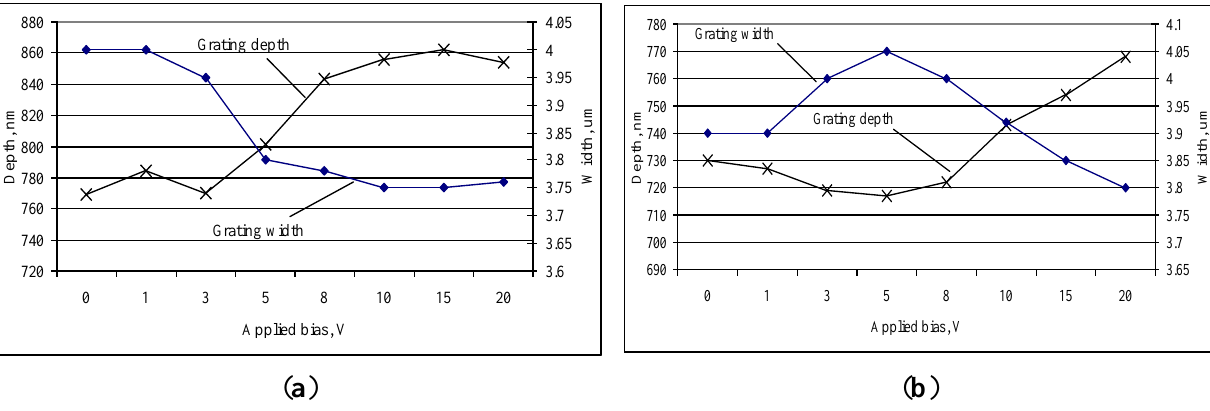
Figure 5. Changes of grating geometry under applied bias ( a ) PVDF-PMMA-Ag and ( b ) PVDF-PMMA-BaTiO -Ag. 3